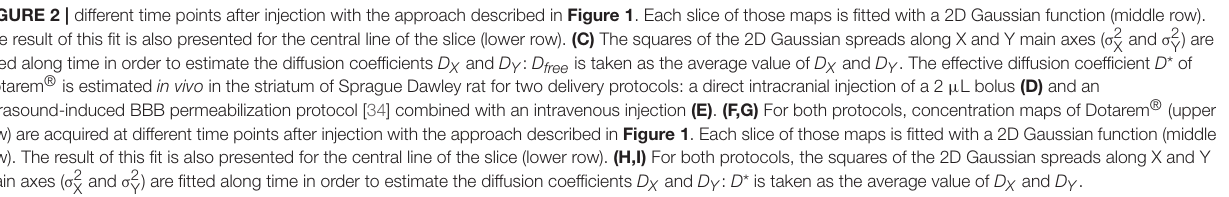
FIGURE 2 | different time points after injection with the approach described in Figure 1 . Each slice of those maps is fitted with a 2D Gaussian function (middle row). The result of this fit is also presented for the central line of the slice (lower row). (C) The squares of the 2D Gaussian spreads along X and Y main axes ( σ 2 X and σ 2 Y ) are fitted along time in order to estimate the diffusion coefficients D X and D Y : D free is taken as the average value of D X and D Y . The effective diffusion coefficient D * of Dotarem ® is estimated in vivo in the striatum of Sprague Dawley rat for two delivery protocols: a direct intracranial injection of a 2 µ L bolus (D) and an ultrasound-induced BBB permeabilization protocol [34] combined with an intravenous injection (E) . (F,G) For both protocols, concentration maps of Dotarem ® (upper row) are acquired at different time points after injection with the approach described in Figure 1 . Each slice of those maps is fitted with a 2D Gaussian function (middle row). The result of this fit is also presented for the central line of the slice (lower row). (H,I) For both protocols, the squares of the 2D Gaussian spreads along X and Y main axes ( σ 2 X and σ 2 Y ) are fitted along time in order to estimate the diffusion coefficients D X and D Y : D * is taken as the average value of D X and D Y